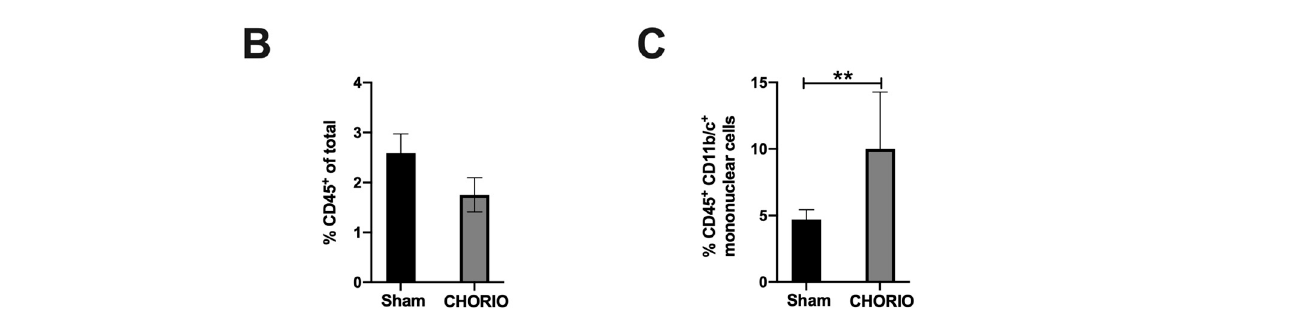
Figure 6. CHORIO-induced increase in brain mononuclear cells at P7. Single cells, live cells and CD45 + CD11b/c positive mononuclear cell population were identified by sequential gating. CD45 FMO and CD11b/c FMO controls were utilized to identify gating boundaries as shown in ( A ). No change in total CD45 + was detected between CHORIO and sham brains ( p > 0.05, not normally distributed, Mann–Whitney) ( B ). Significant increase in the percentage of CD45 + CD11b/c + mononuclear cells in CHORIO brains at P7 compared with sham (** p = 0.0098, normally distributed, Welch’s t -test, mean ± SEM), ( C ).